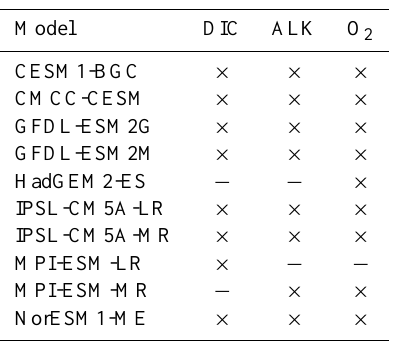
Table 1. CMIP5 models considered for each variable (“ × ” for yes, and “ − ” for